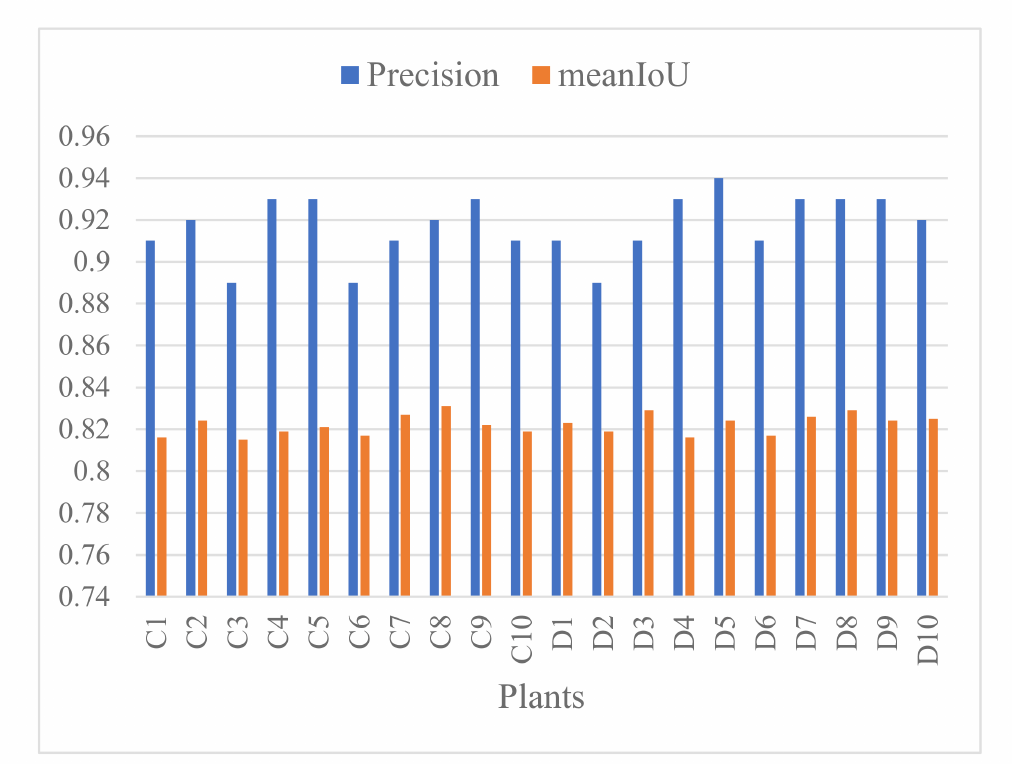
Figure 11. Flower detection performance of sunflower plants from FlowerPheno dataset using average precision and mean